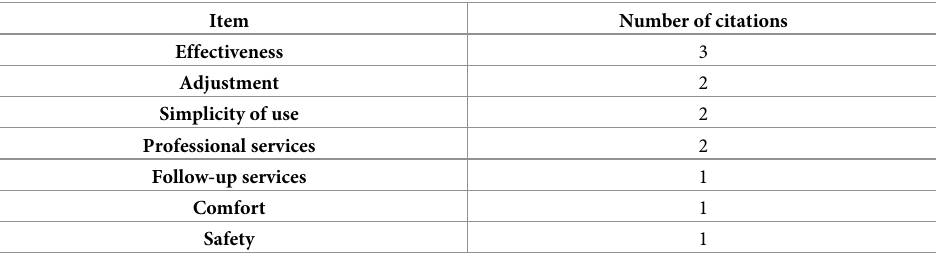
Table 5. Important items regarding the SE